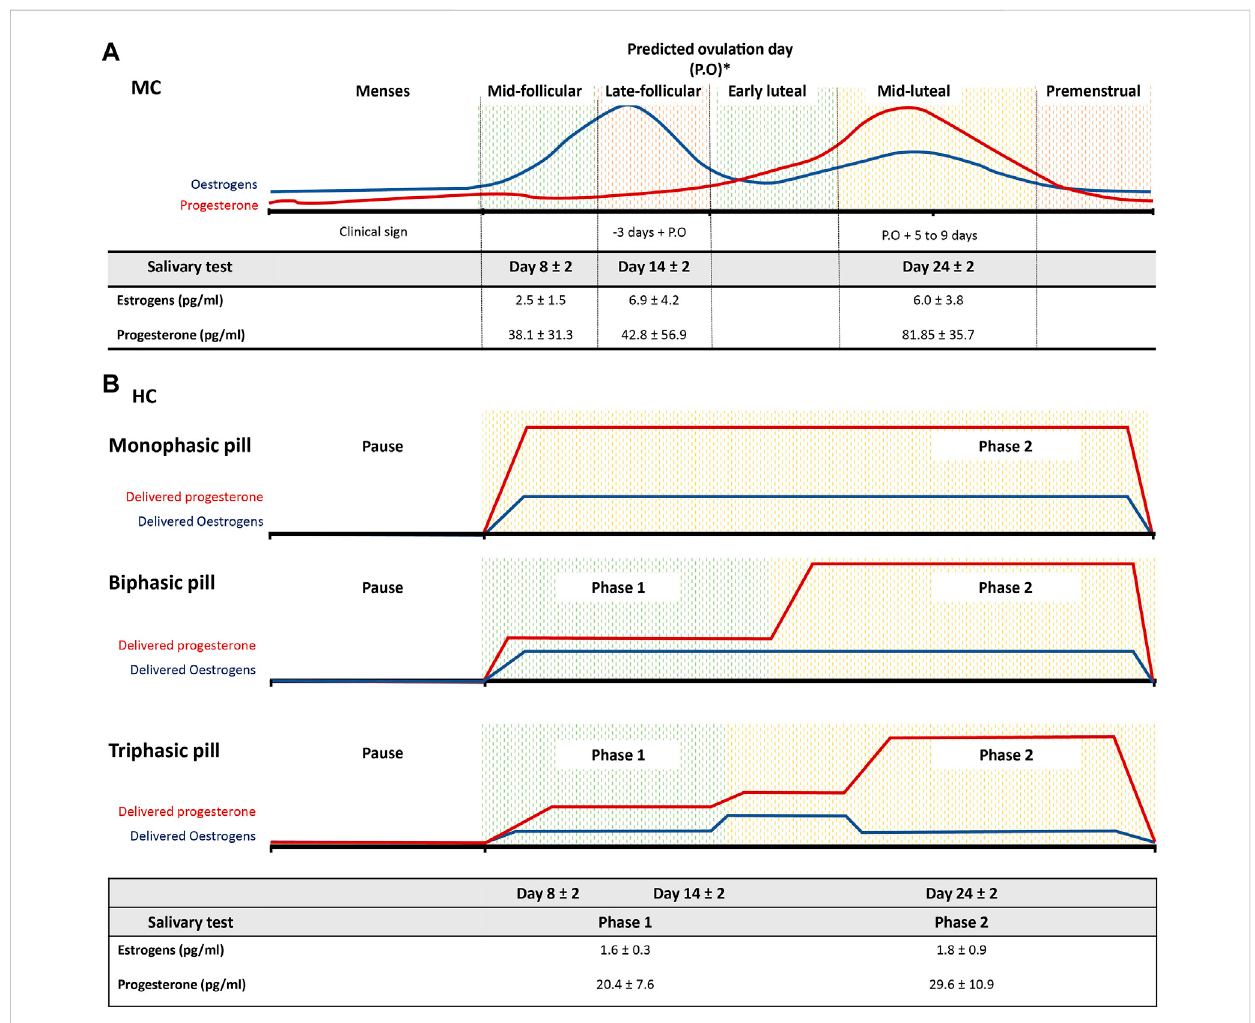
FIGURE 1 Schematic representation of the phases ’ classi fi cation among French women elite rowers. (A) six phases division for natural menstrual cycle (MC) rowersbased on thepredicated ovulationday (P.O)and acalendar counting. The table displays thesalivarylevels (pg/mL) of estrogens and progesterone taken during days 8, 14 and 24 ± 2 days and the corresponding sub-phases following the schematic classi fi cation for both MC and (B) rowers using hormonal contraception (HC). Two to three phases division according to the type of pills composition for where pause corresponds to the pill